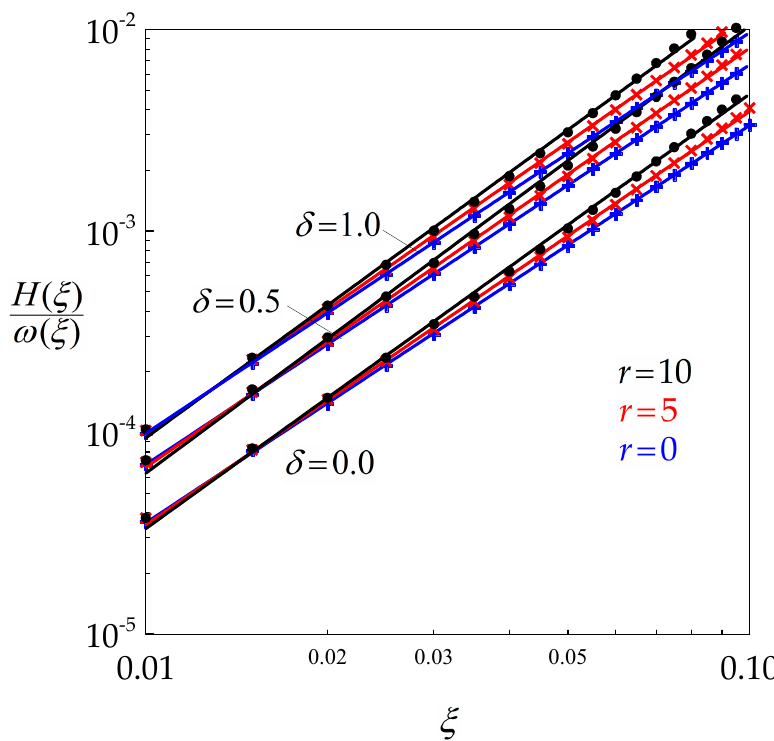
Figure 4. Double logarithmic diagram highlighting the power law dependence of H ( ξ ) / ω ( ξ ) with respect to ξ for various values of r and δ .